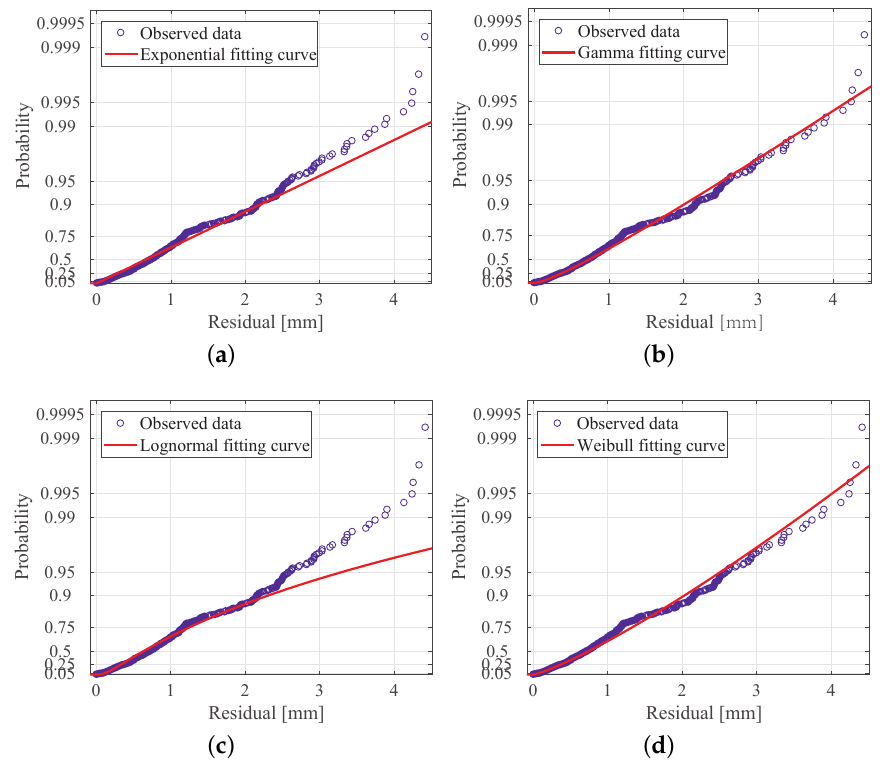
Figure 10. Univariate cumulative distribution function (CDF) fitting curves of | ε | 9 − 3 : ( a ) Exponential distribution function, ( b ) Gamma distribution function, ( c ) Lognormal distribution function, ( d ) Weibull distribution